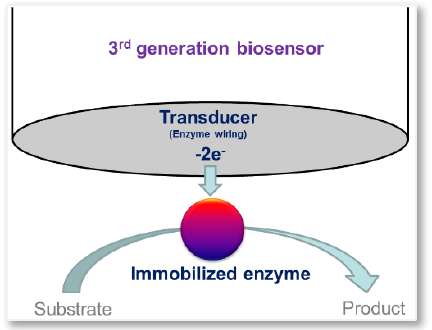
Figure 3. Simplified drawing of a third generation biosensor.